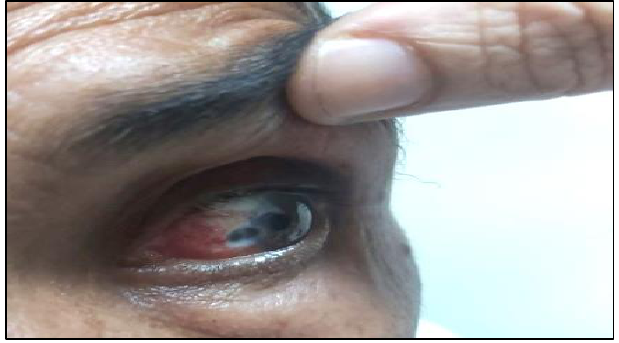
Fig. 3. Recurrence of scleral & corneal thinning 13 days after surgery.